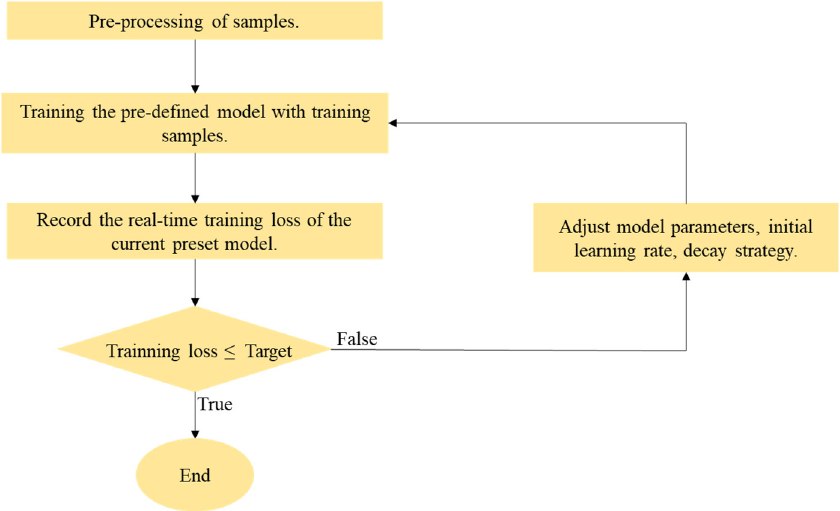
Figure 3. Flowchart of ED Net training.